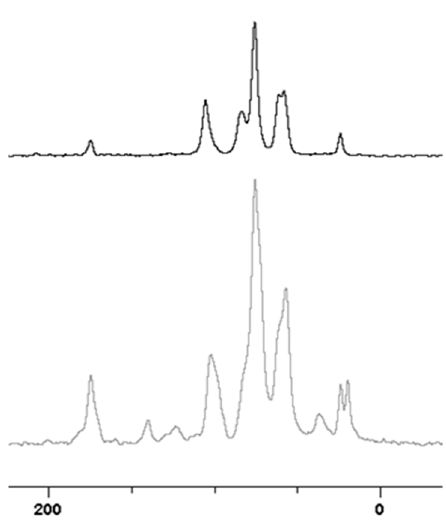
Figure 5. 13 C solid state NMR spectra. ( Top ) Unmodified CS; ( Bottom ) Modified CS. N.B. X-axis in ppm.